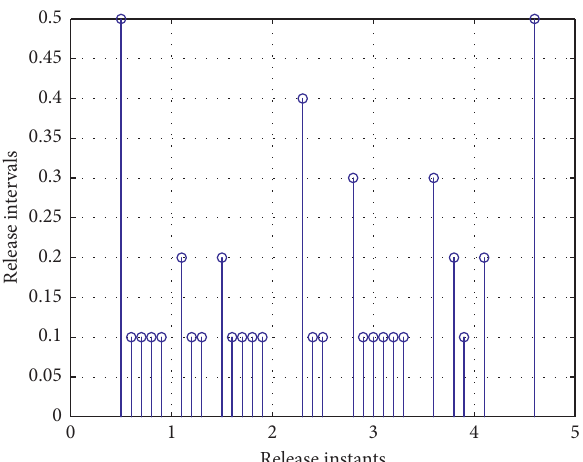
Figure 3: Release instants and intervals for Example 1 under AEIC.